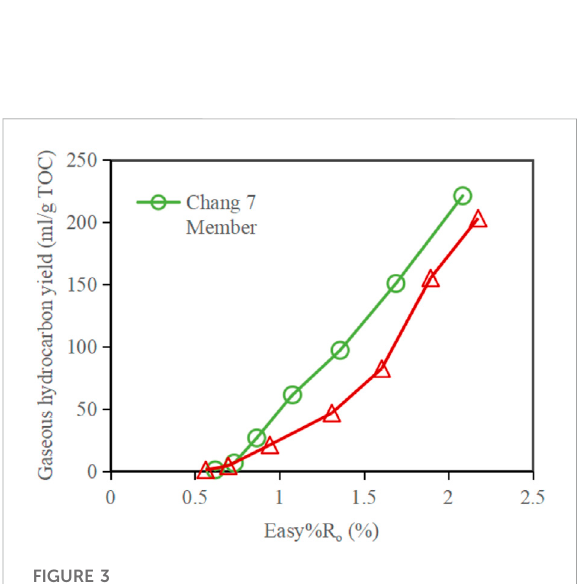
FIGURE 3 Comparison of kerogen gas generation potential between the Yanchang Formation shale and the Barnett